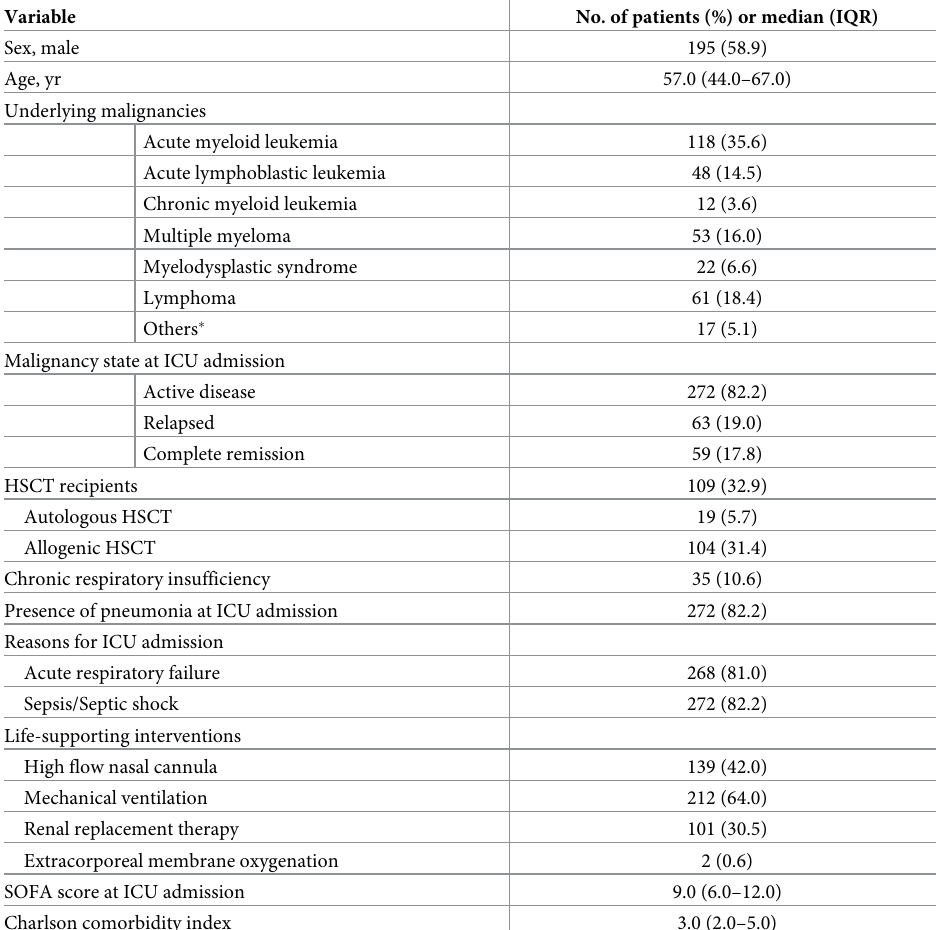
Table 1. Baseline characteristics of